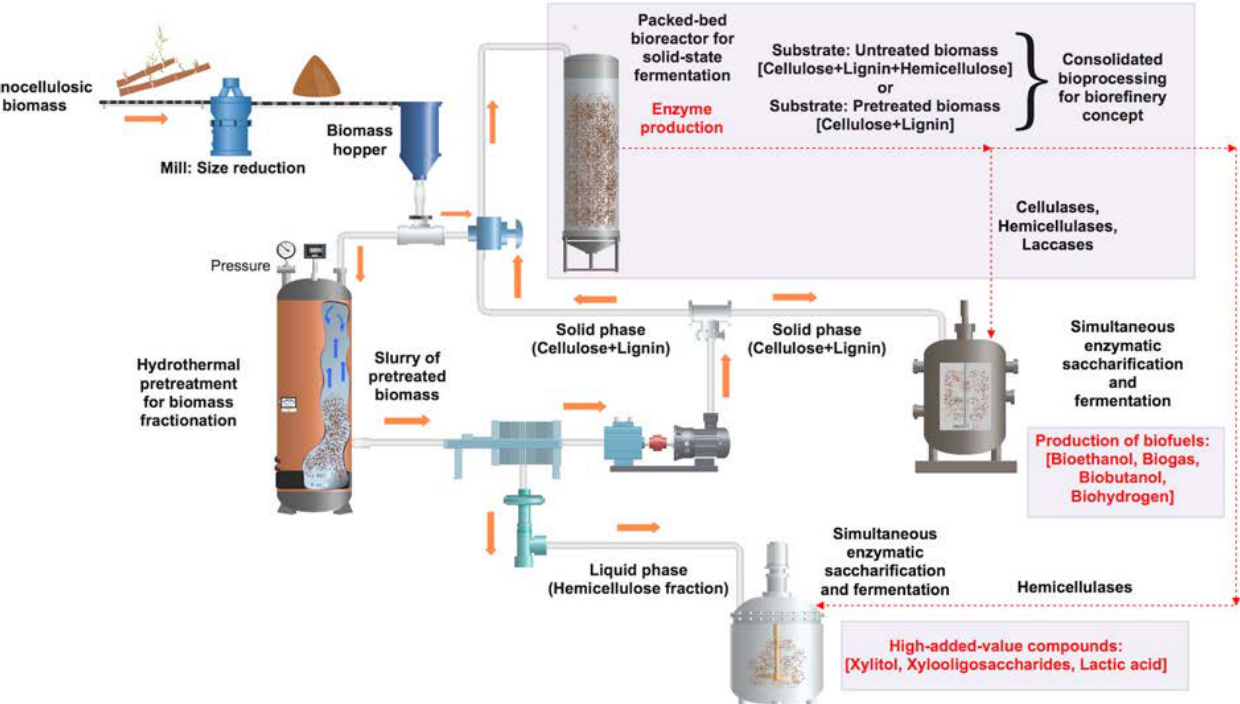
Figure 1. Schematic representation of a general biorefinery process for lignocellulosic biomass fractionation showing the production of enzymes by SSF, using a packed-bed bioreactor.